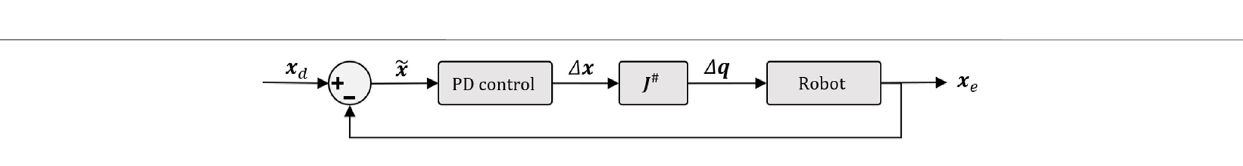
FIGURE 3 | Control scheme of the classical